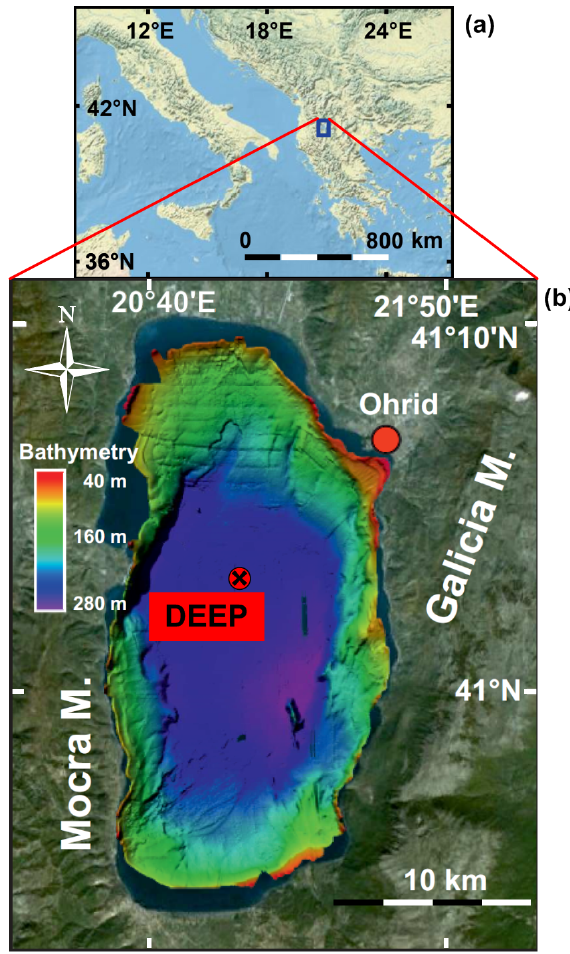
Figure 1. (a) Regional map of Lake Ohrid in the Mediterranean region and (b) bathymetric map of the lake. The city of Ohrid and the DEEP drill site from the ICDP campaign are shown (modified after Wagner et al.,